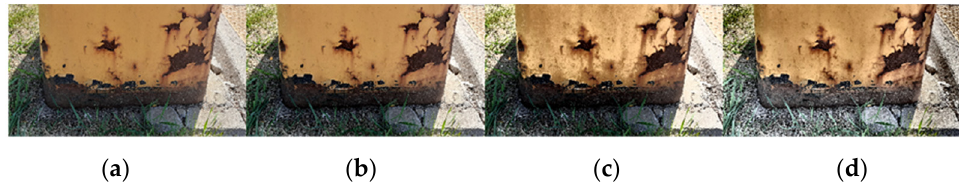
Figure 6. ( a ) Original image; ( b ) enhanced image; ( c ) image after applying histogram equalization; ( d ) image after applying adaptive histogram equalization. ( d ) image after applying adaptive histogram